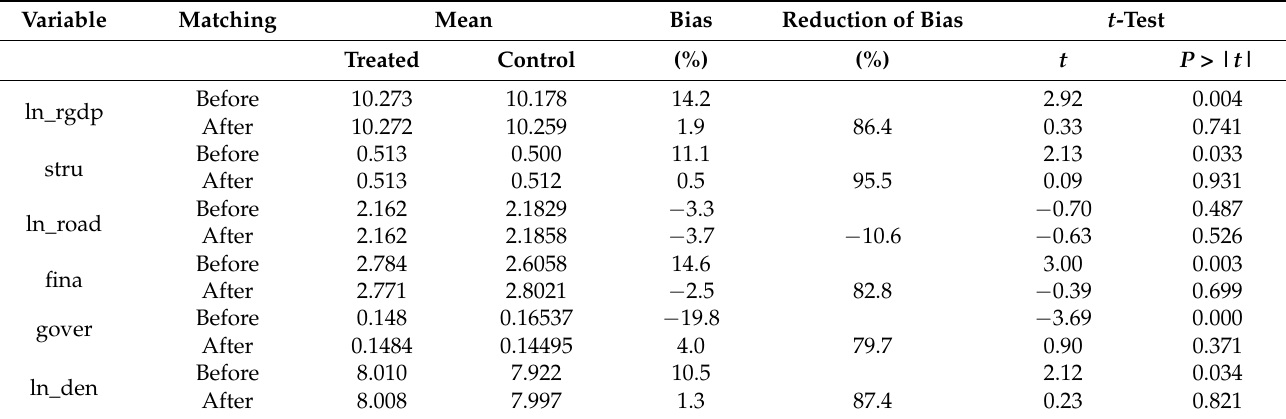
Table 5. Balance test